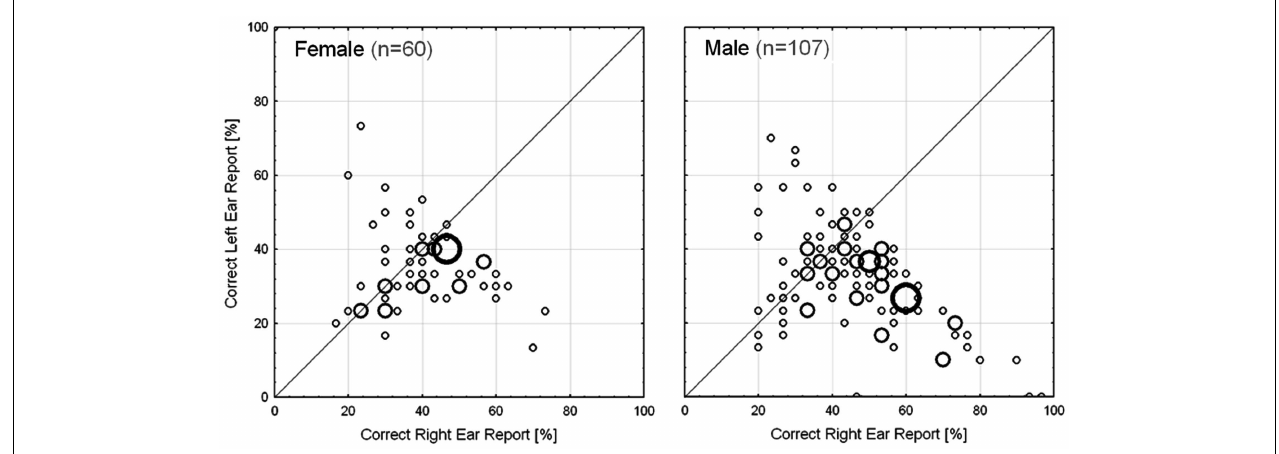
FIGURE 4 | Distribution of the field data separated by sex; collected via iDichotic. Size of bubble reflects the number of subjects with the same ear scores (displayed as percentage correct reports of right and left ear stimulus in one test run). Left: female subjects; right: male subjects.